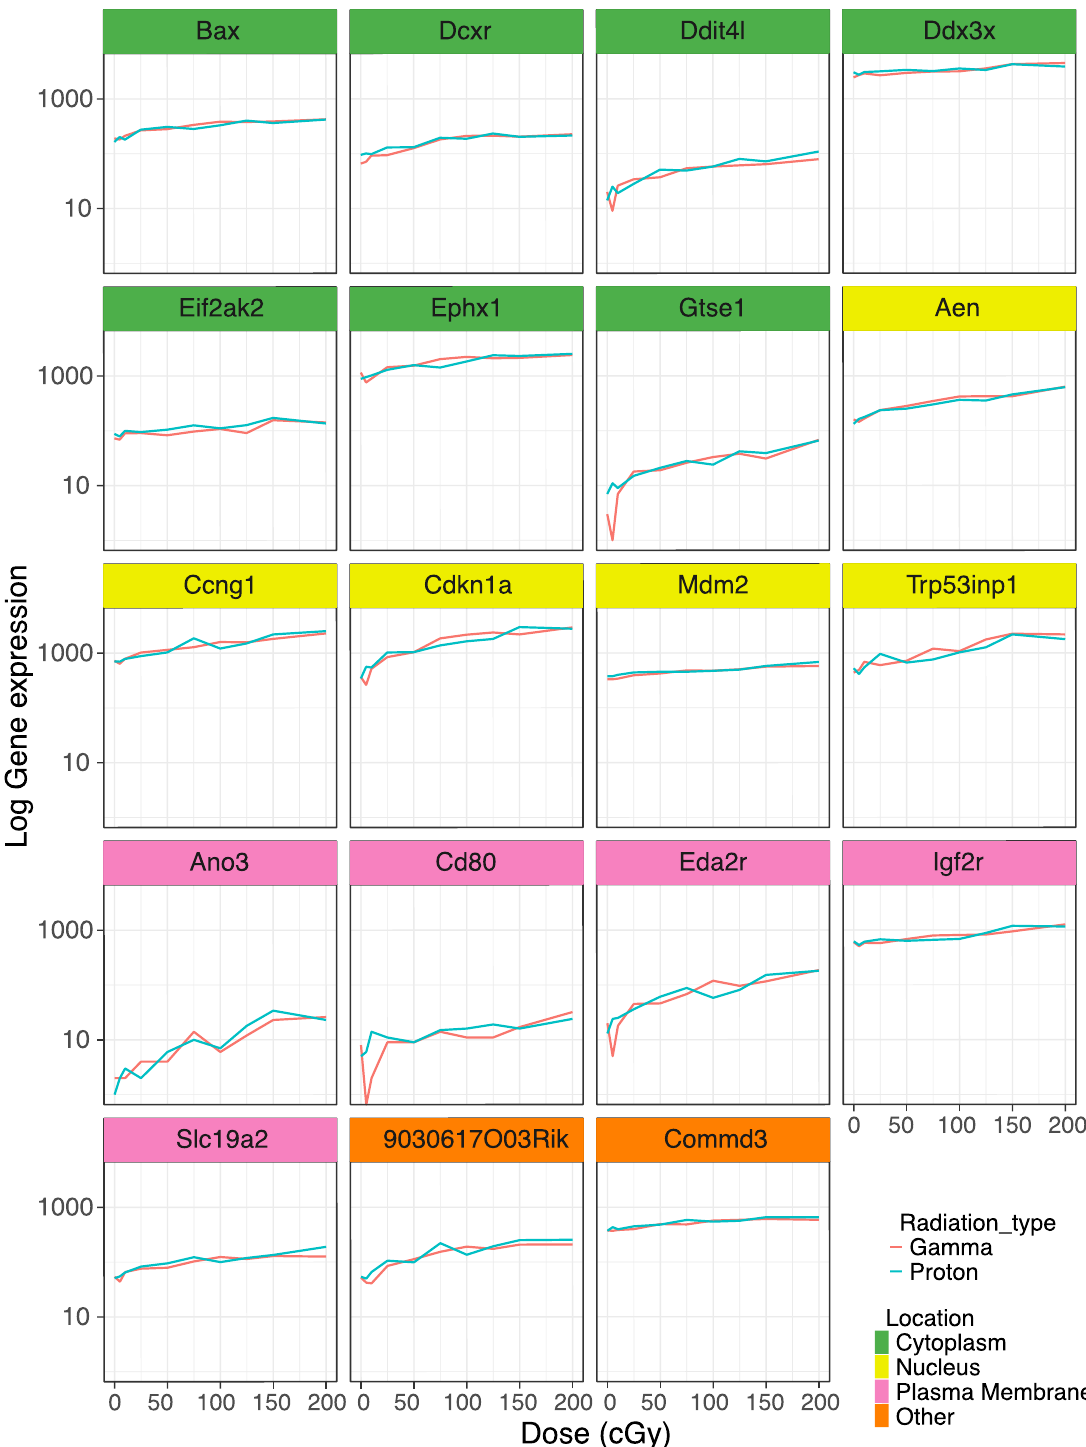
Fig 4. Highly dose-responsive genes upregulated by both proton and gamma radiation. Expression profiles of genes that showed a significant dose-dependent response in the trend analysis ( q -value � 0.1).